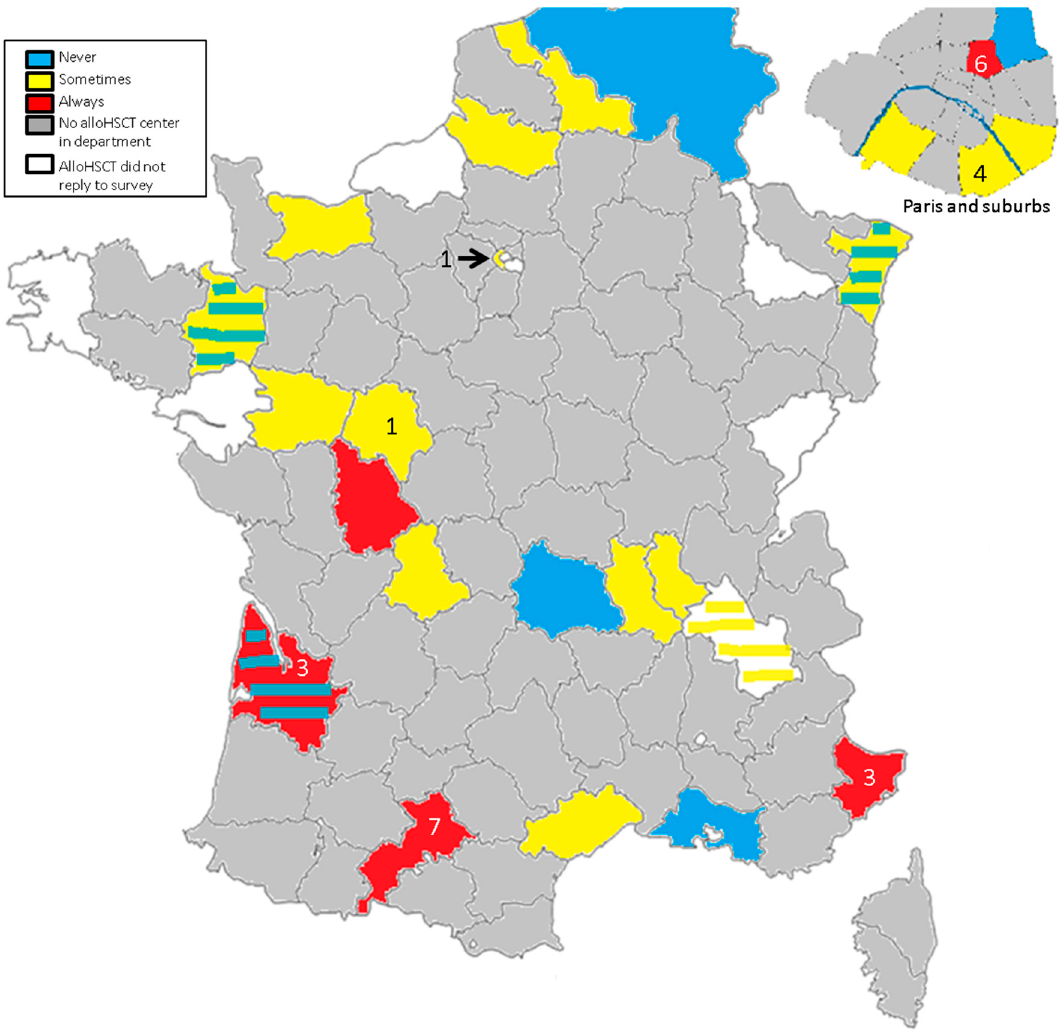
Figure 1. Awareness of centers of the burden of hepatitis E virus (HEV) and breakdown of cases. Color code describes the frequency of HEV search in cases of liver function tests abnormalities. Numbers indicate the number of cases diagnosed in each center. Stripes indicate the different diagnostic procedures for adult and pediatric centers in the same department.